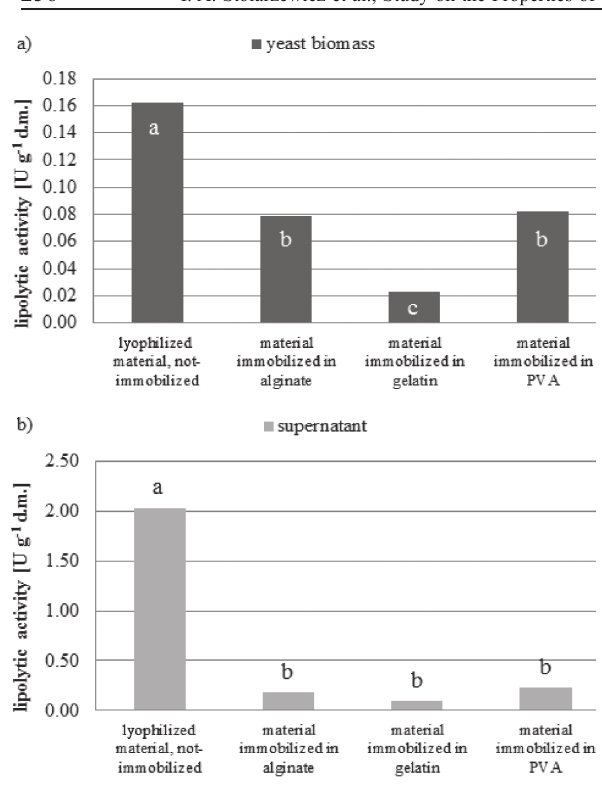
Fig. 5 – Effect of immobilization on the lipolytic activity of freeze-dried yeast cell biomass Y. lipolytica KKP 379 (a) and lyophilized supernatant (b) from 40 h culture. Homogeneous groups designated on the basis of Welch’s test (a) and ANOVA test (b) test were identified by letters. Means were separated into statistically different groups (a or b). Activity of the free supernatant translated from U mL –1 on U g –1 d.m. taking into account the percentage of dry matter equal to 2.7